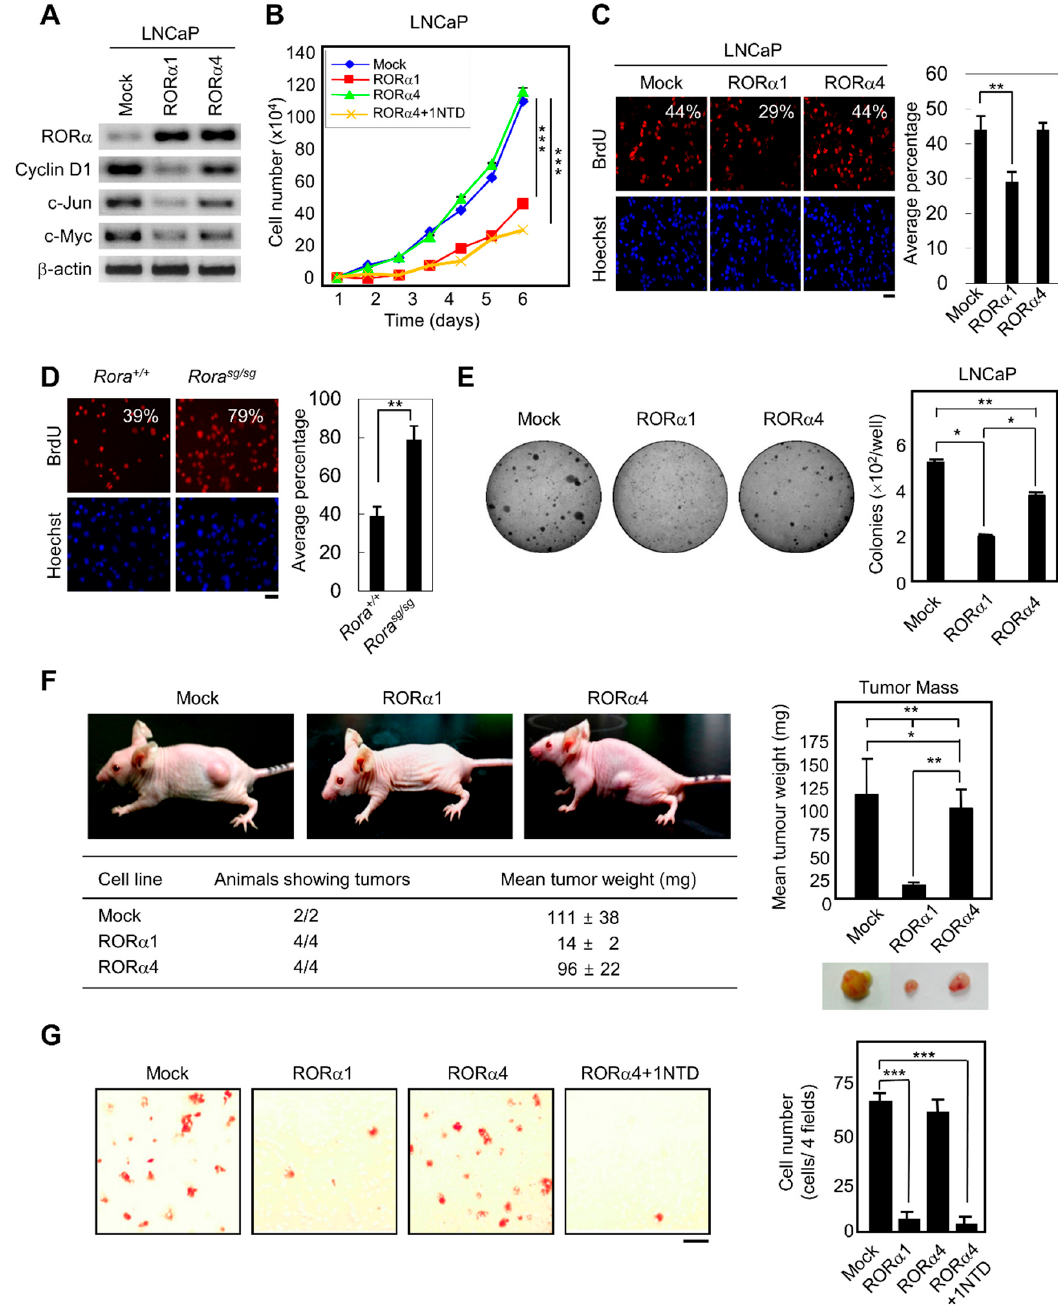
Figure 3. ROR α 1-mediated inhibition of in vivo tumorigenesis and metastatic potential. ( A ) RT-PCR analysis of the Wnt target gene transcripts after overexpressing either ROR α 1 or ROR α 4 in LNCaP cells. ( B ) Proliferation curves of ROR α 1, ROR α 4 or ROR α 4 + 1NTD-expressing LNCaP cells. Values are represented as mean ± SD for three independent experiments (mean ± SD, n = 3). The p value was calculated by a t -test (*** p < 0.001). ( C and D ) BrdU incorporation in LNCaP, ROR α 1, ROR α 4-expressing LNCaP cells ( C ) and Rora +/+ , Rora sg/sg MEFs ( D ) (Red fluorescence, left) compared to the total number of nuclei (Hoechst staining, right). The average percentage of BrdU incorporated cells from three different fields is indicated (mean ± SD, n = 3). The p value was calculated by a t -test (** p < 0.01). Scale bar, 20 µ m. ( E ) The anchorage-independent growth of LNCaP cells expressing ROR α 1 or ROR α 4 in soft agar. Values are expressed as mean ± SEM for two experiments in 6-well plates. The representative image is shown for each group. The p value was calculated by a t-test (* p < 0.05) or one-way ANOVA (** p < 0.01). ( F ) Subcutaneous tumor growth of LNCaP cells expressing ROR α 1 or